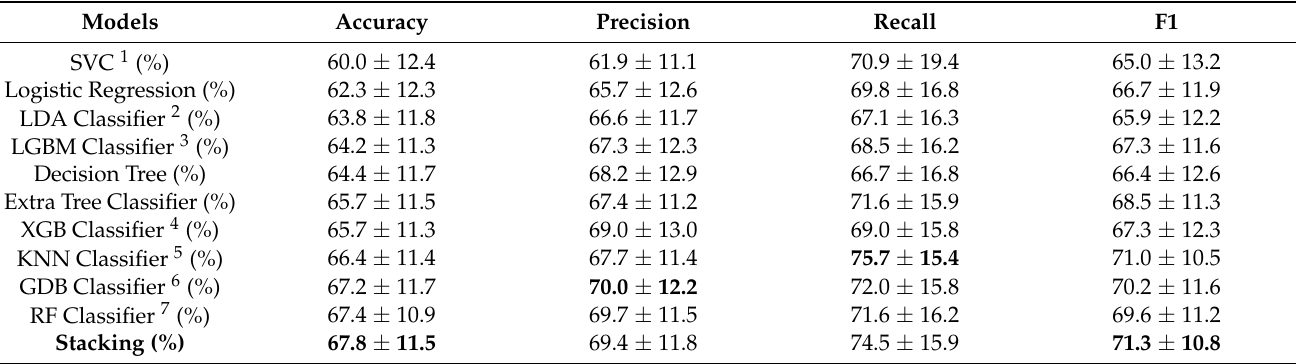
Table 3. Baseline demographic characteristics of the